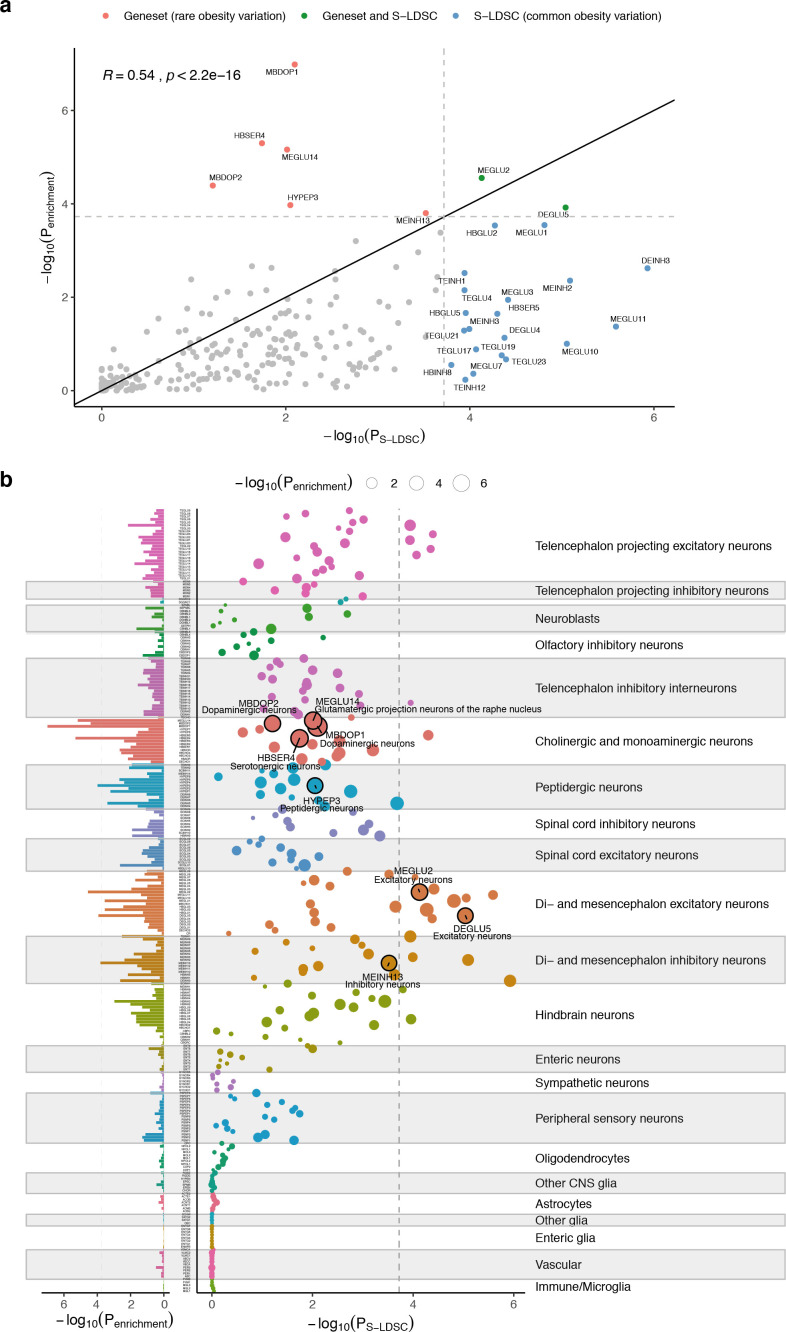
Convergence of cell type prioritization based on common and rare variants.(a) Cell type prioritization of high-confidence obesity genes enrichment results (bar chart, left part) and BMI GWAS-enrichment results (bubble chart, right part). Circle sizes represent the -log10(Penrichment) cell type enrichment of the high-confidence obesity genes. Circles with black edges mark cell types passing the Bonferroni significance threshold (Penrichment <0.05/265). Bar chart (left plot) shows the distribution of -log10(Penrichment) across all cell types. Dashed lines indicate Bonferroni significance threshold. Cell types are grouped by the cell type taxonomy shown in Figure 3b. (b) Comparison of cell type BMI GWAS-enrichment and high-confidence obesity genes enrichment-based results. Cell type BMI GWAS-enrichment (x-axis) and cell type enrichment of high-confidence obesity genes (y-axis). Pearson’s correlation (R) is shown in the top left corner. Dashed lines indicate cell types passing the Bonferroni significance threshold. Solid line shows x = y relationship.